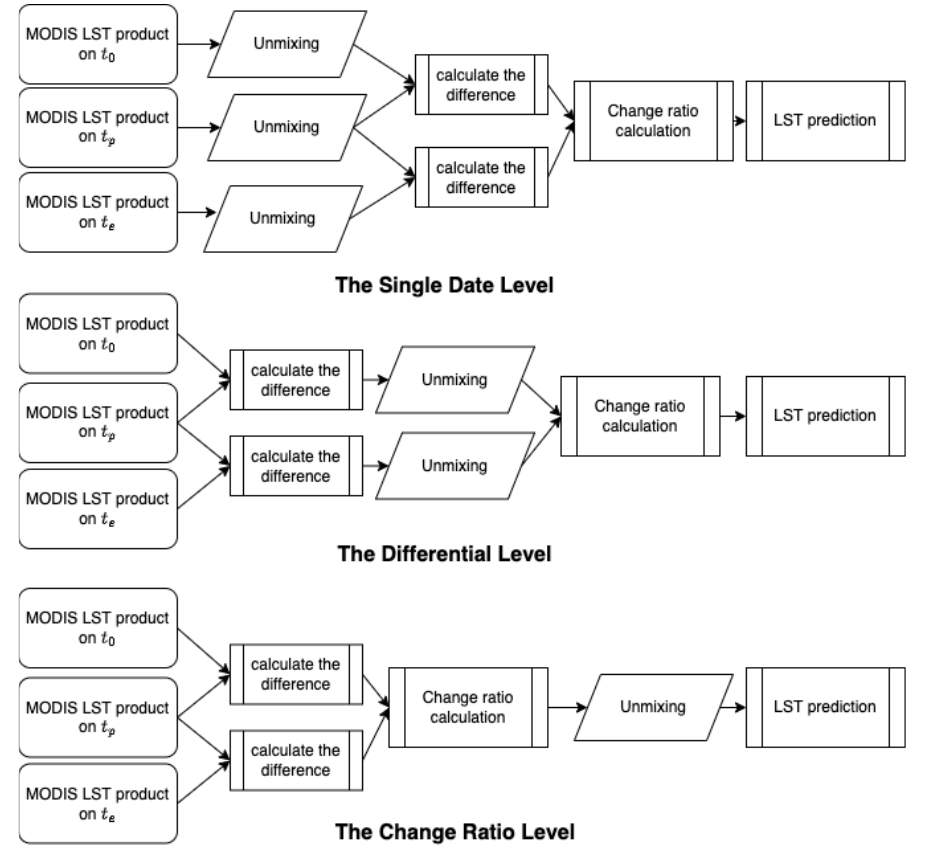
Figure 5. The different levels of the unmixing.